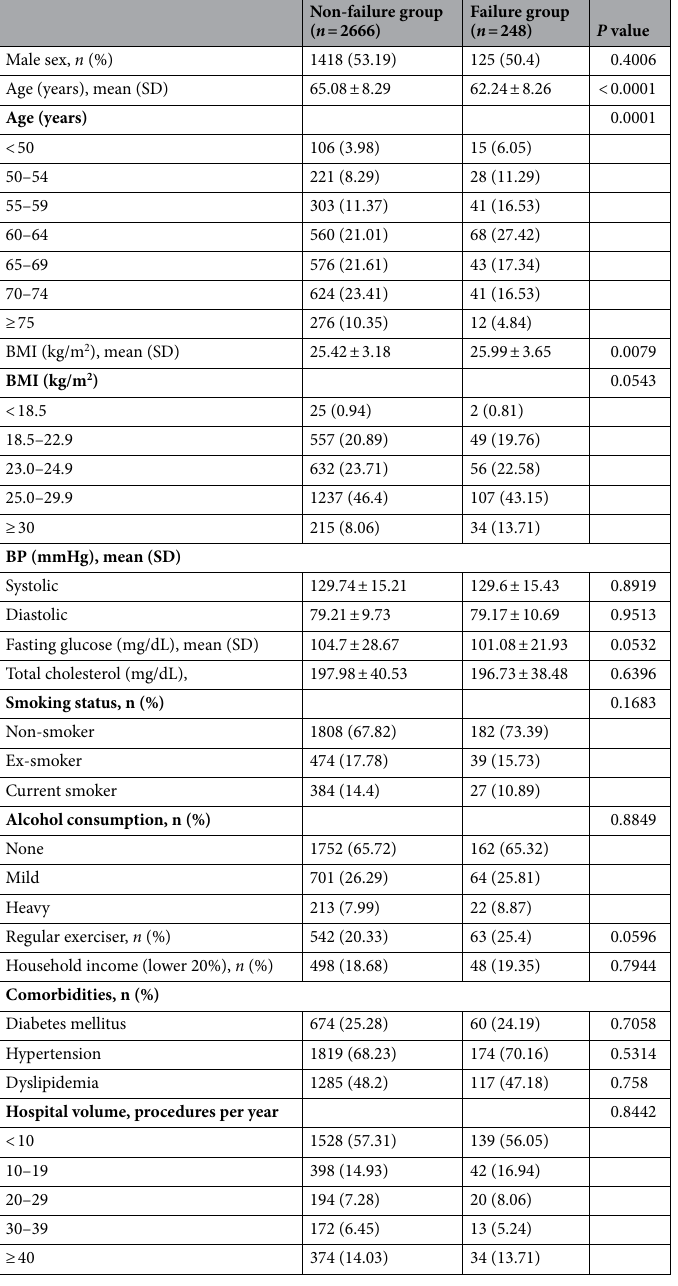
Table 1. Baseline characteristics of study